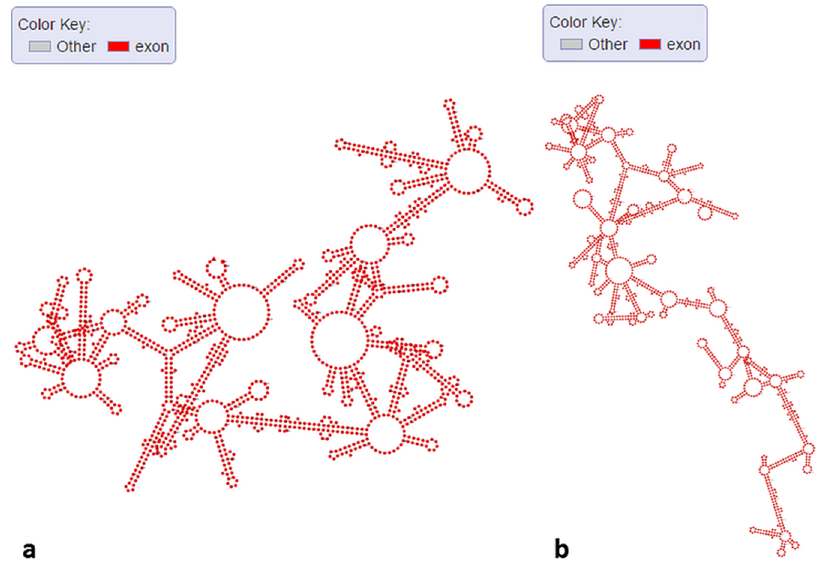
Fig 4. Secondary structure graphs of a selected rRNA in Arabidopsis . (a) rRNA (Ensembl ID “ATCG00920.1”)without experimental data as constraints.(b) rRNA (Ensembl ID “ATCG00920.1”)with experimental data as constraints.